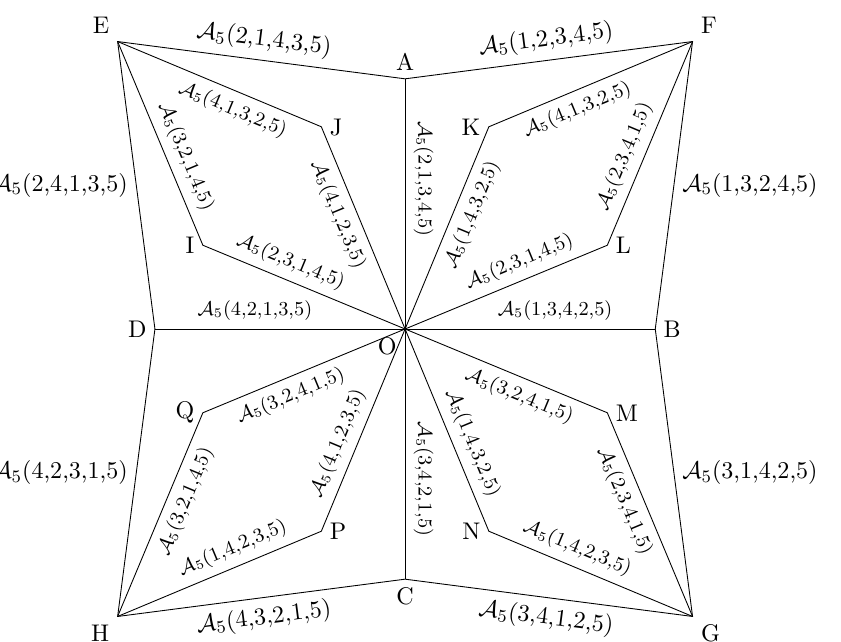
Figure 10. An extended version of combined Plahte diagram containing all possible color-ordered scattering